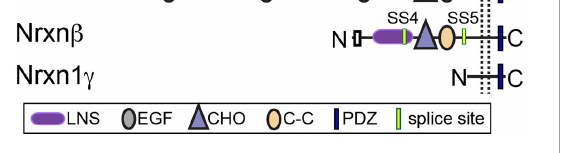
FIGURE1 Neurexin structure. Nrxns are encoded from three genes (Nrxns 1–3). α -Nrxns (1–3) contain 6 LNS domains, 3 EGF-like-repeats, and up to 6 sites of alternative splicing. β -Nrxns (1–3) contain LNS6 and splice sites 4 and 5. γ -Nrxn (Nrxn1 only) is highly truncated. Reproduced with permission from Boxer et al.